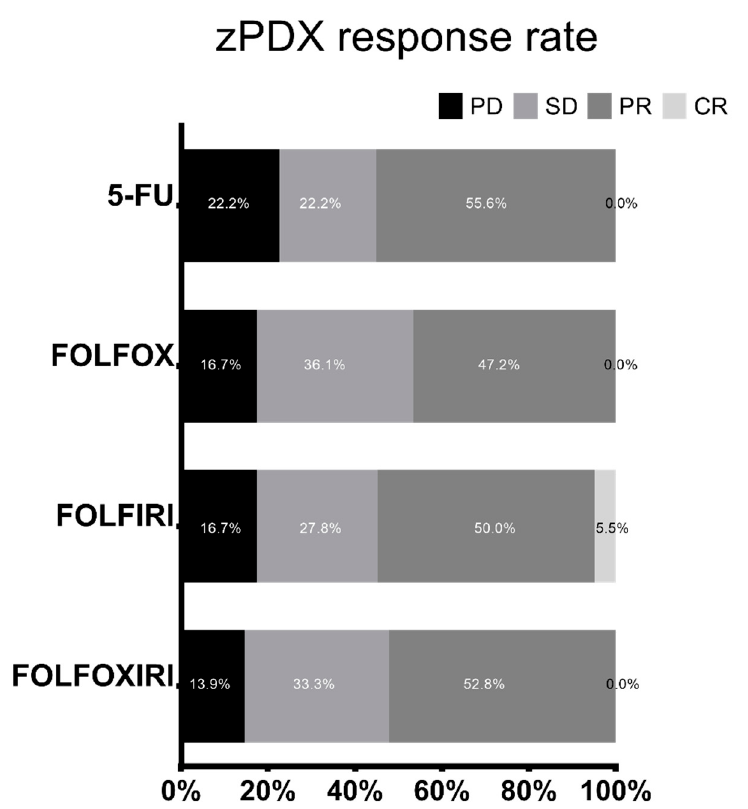
Figure 5. Percentage of progressive disease (PD), stable disease (SD), partial response (PR), and complete response (CR). 5-FU, FOLFOX, FOLFIRI and FOLFOXIRI treatments in zebrafish avatars xenotransplanted with colorectal tumor ( n = 36 patient samples analyzed).